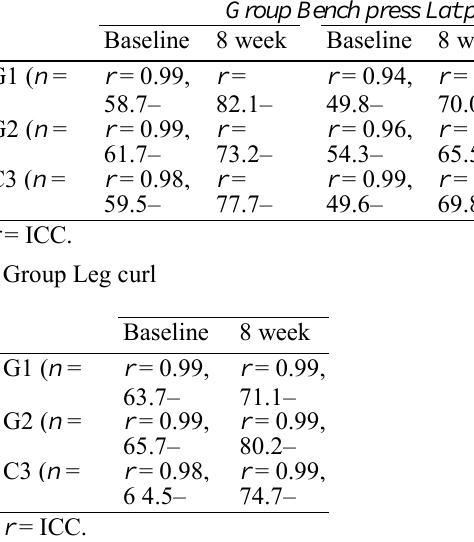
Intra-class correlation coefficients (ICC) and range values in kg for each exercise, between 1RM tests and retests at baseline and after 8